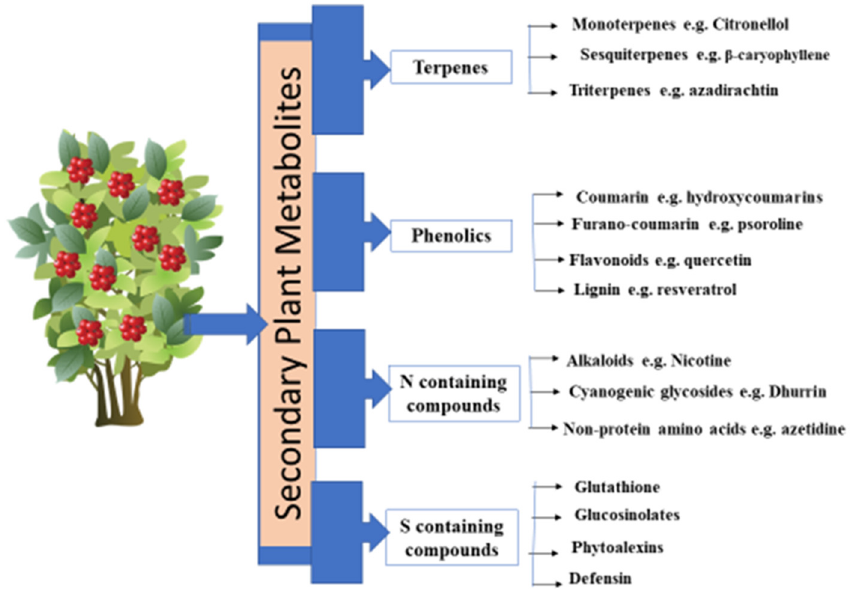
Figure 1. Types of secondary metabolites.